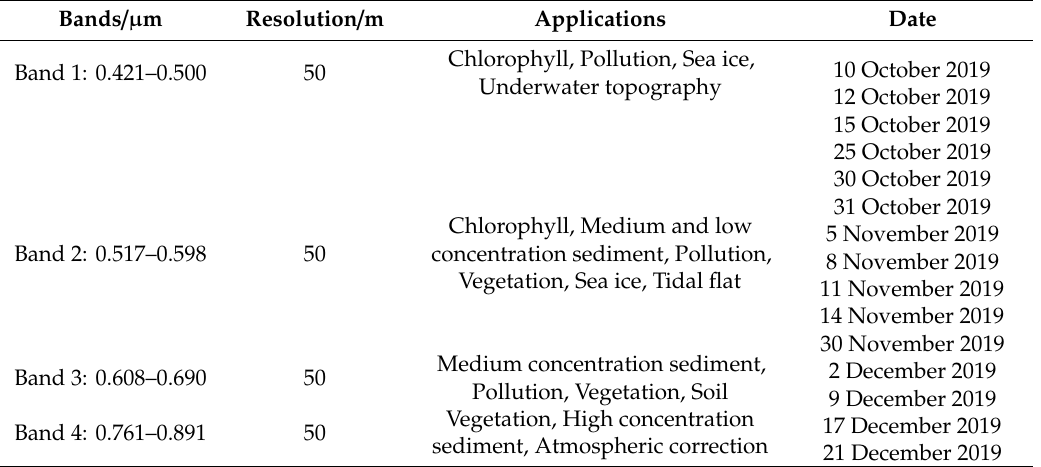
Table 1. Details of HY-1C Coastal Zone Imager (CZI) sensor and date of data acquisition. Bands / µ m Resolution /